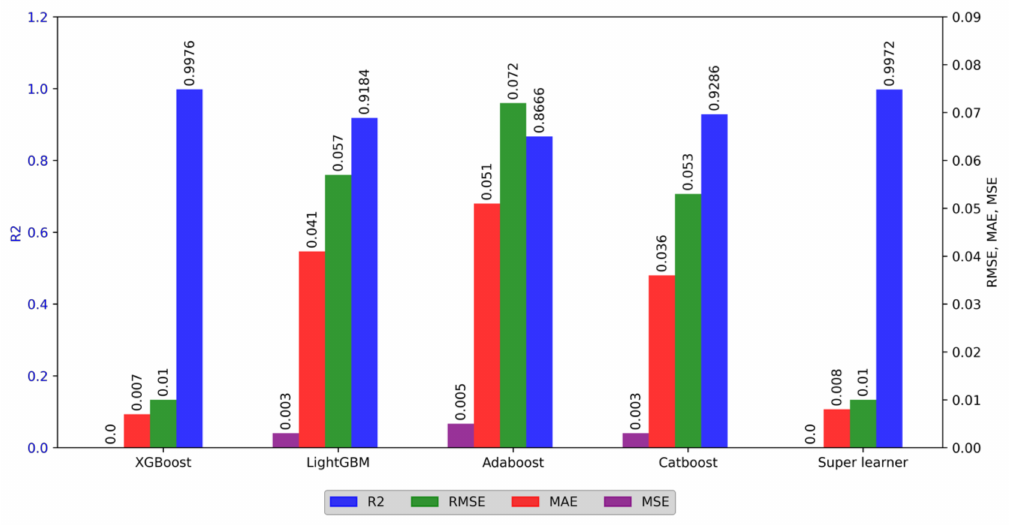
Figure 7. Evaluation metrics for dataset A comparing among various methods. It is observed that Super Learner performs the